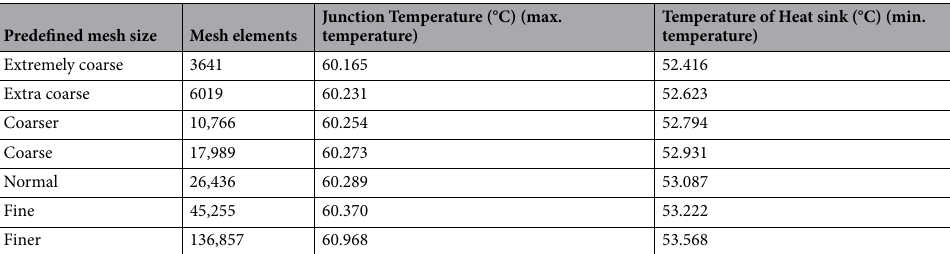
Table 2. Mesh independency of the micro-channel.